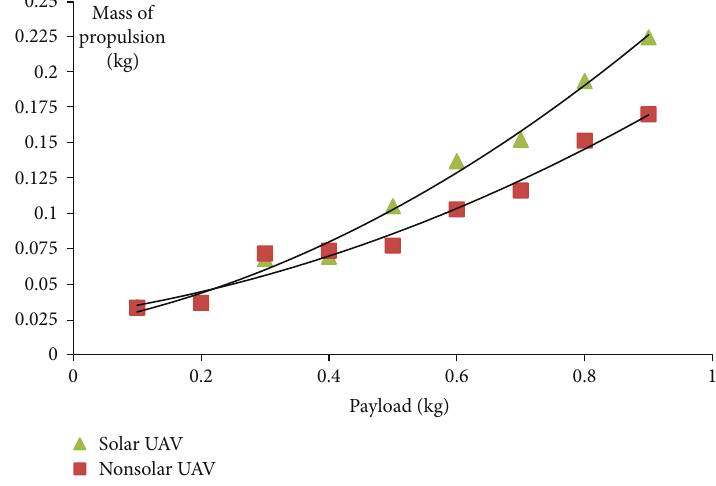
Figure 8: Mass of the payload versus propulsion of the solar and nonsolar